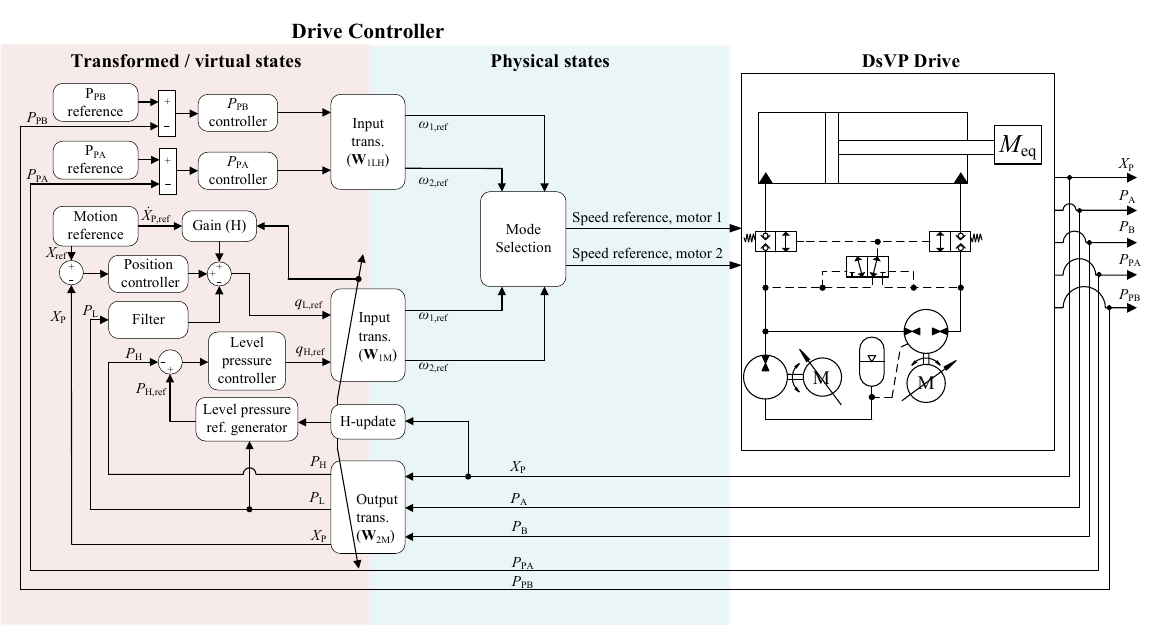
Figure 12: Schematic of the control structure for the proposed system. coupling from p H is negligible. The pressure in the q L,ref low pressure chamber is defined as 30 bar, while the pressure in the load-carrying chamber is defined based on the crane load at a specific piston position. By varying the piston position in the entire stroke length (0m to 2.8m) and the piston speed between min- imum and maximum velocity (-45mm/s to 45 mm/s), the position of the open loop poles as a function of dif- ferent linearisation points are found. This is illustrated in Fig. 13, where it is found that the placement of the pole close to origin is of special interest. It is found that the combination of large retraction velocities and small piston strokes yield this pole to be placed in the right half of the complex plane.